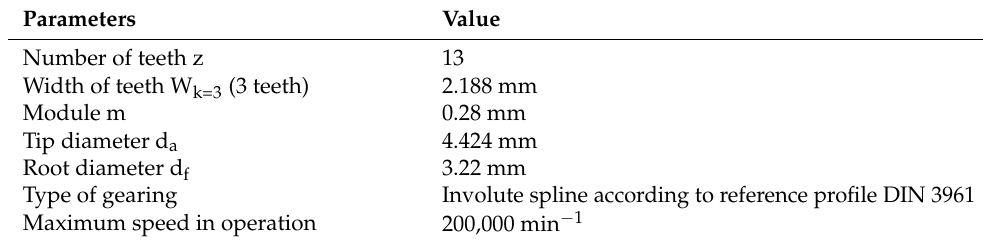
Table 1. Parameters of the investigated microgear.